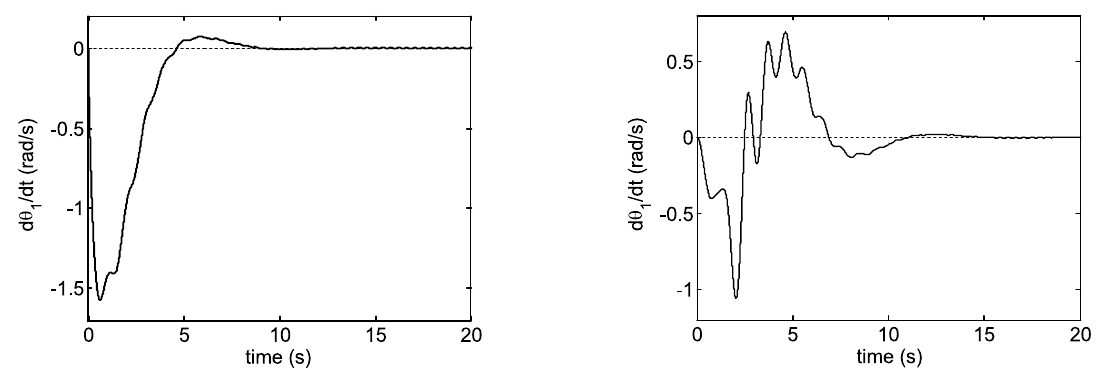
Fig. 9. Estimated behavior of variable ˙ θ 1 considering same initial conditions for the angular displacements.